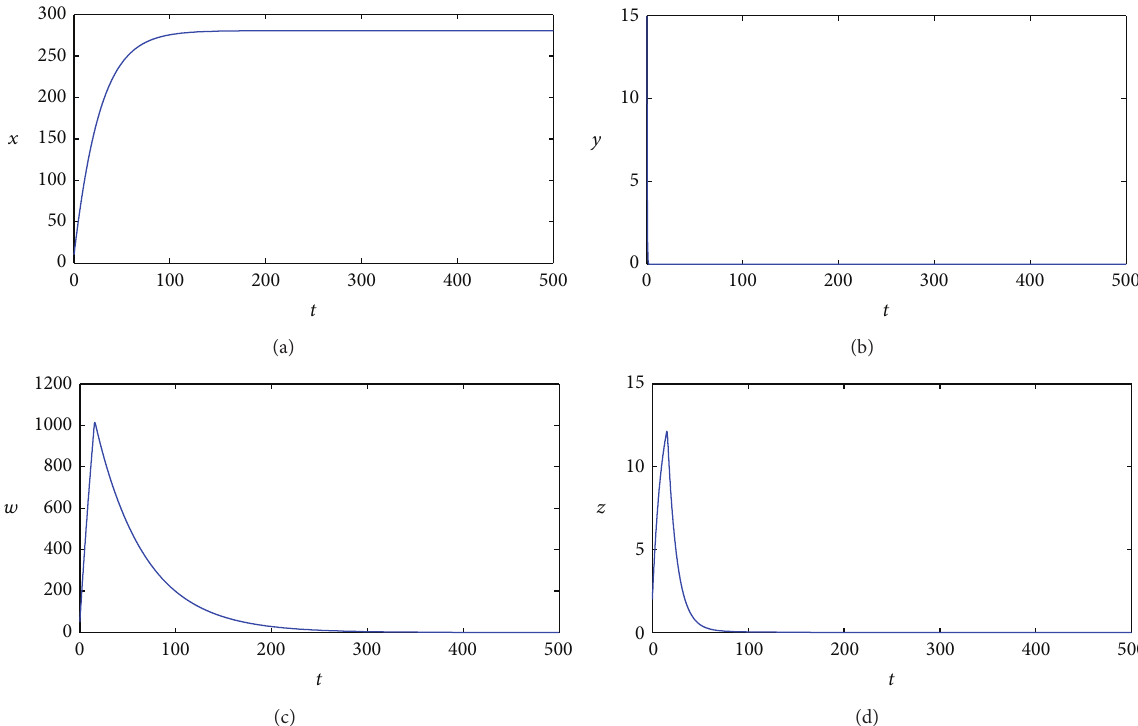
Figure 5: It shows the numerical simulations model (4) when the efficacy rate of antiretroviral treatment is at expected level, 𝜖 = 0.9 and 𝜂 = 0.9 , and the delay value exceeds the critical value 𝜏 = 15 > 𝜏 0 . The solution always lies within the feasible region and the infection-free steady state E 0 is asymptotically